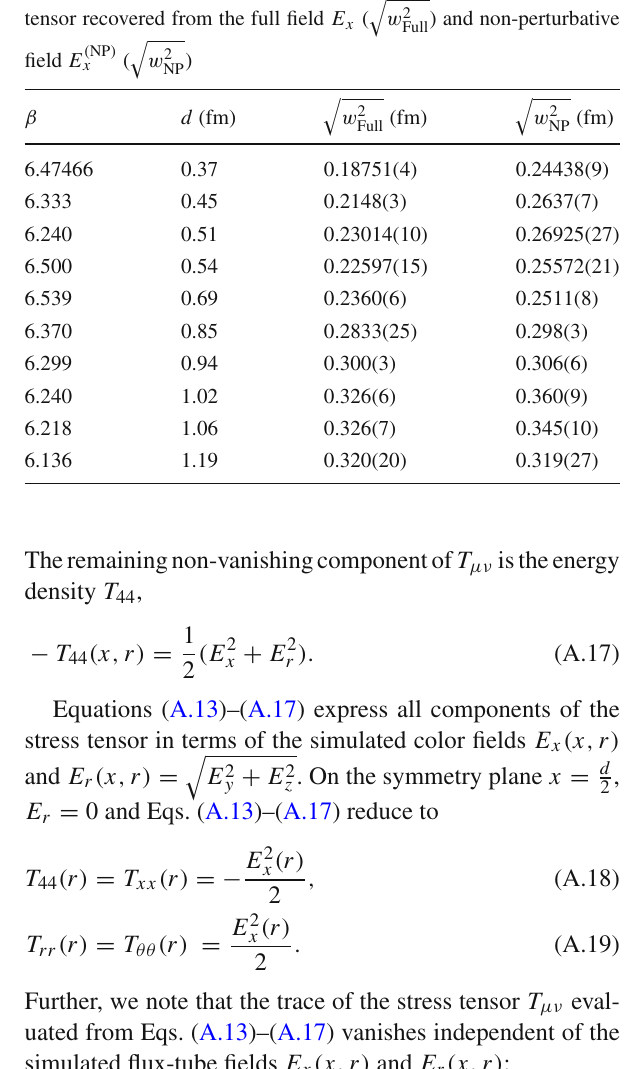
(cid:14) w 2 ) and non-perturbative Full